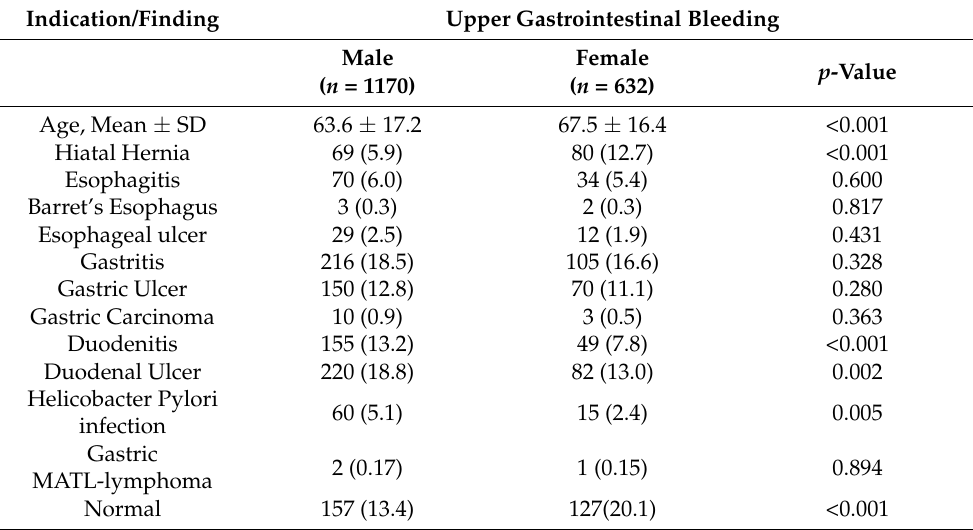
Table 5. Upper endoscopy finding for the indication of gastrointestinal